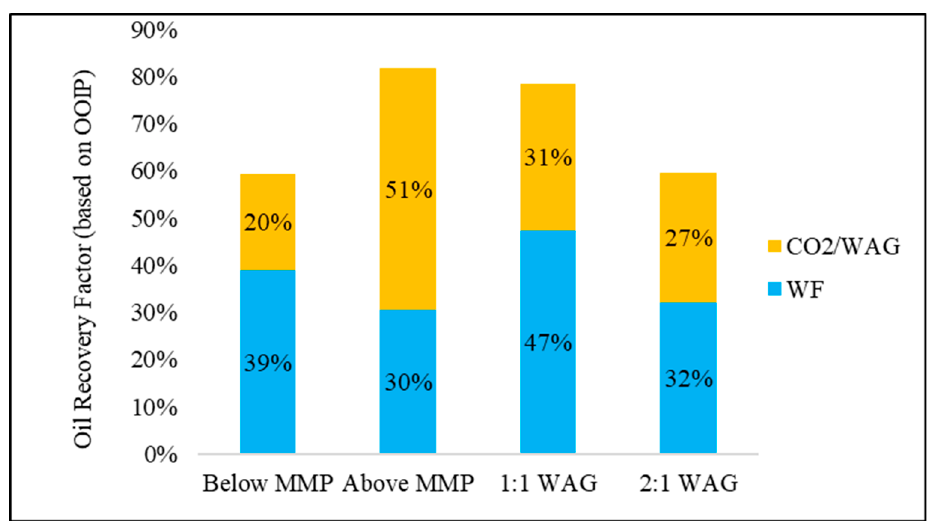
Figure 16. Oil recovery results from Copper Ridge dolomite coreflooding tests.